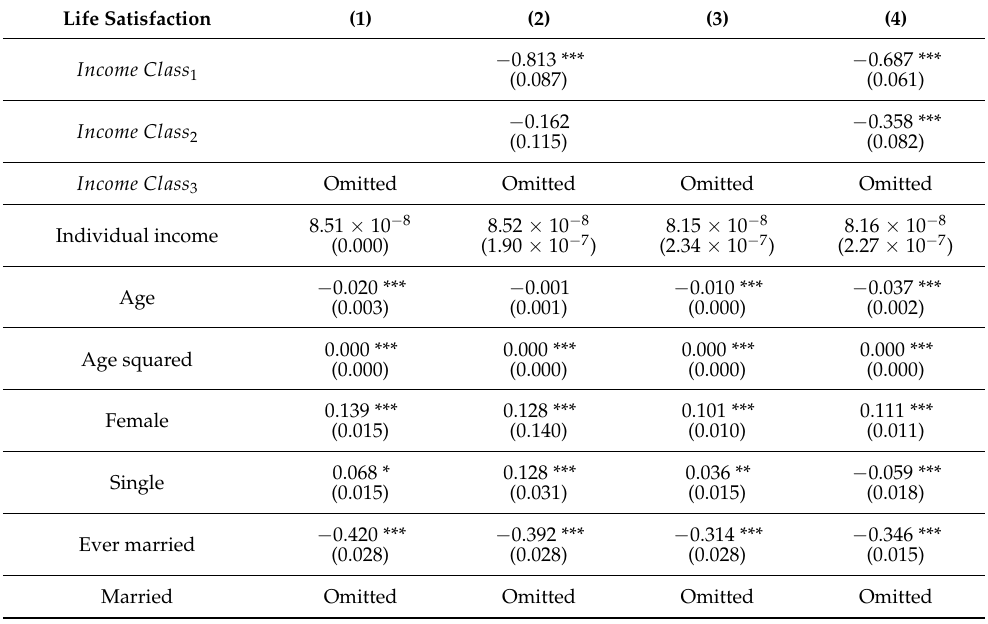
Table 2. Main results: income classes and life satisfaction (ordered response models . . .